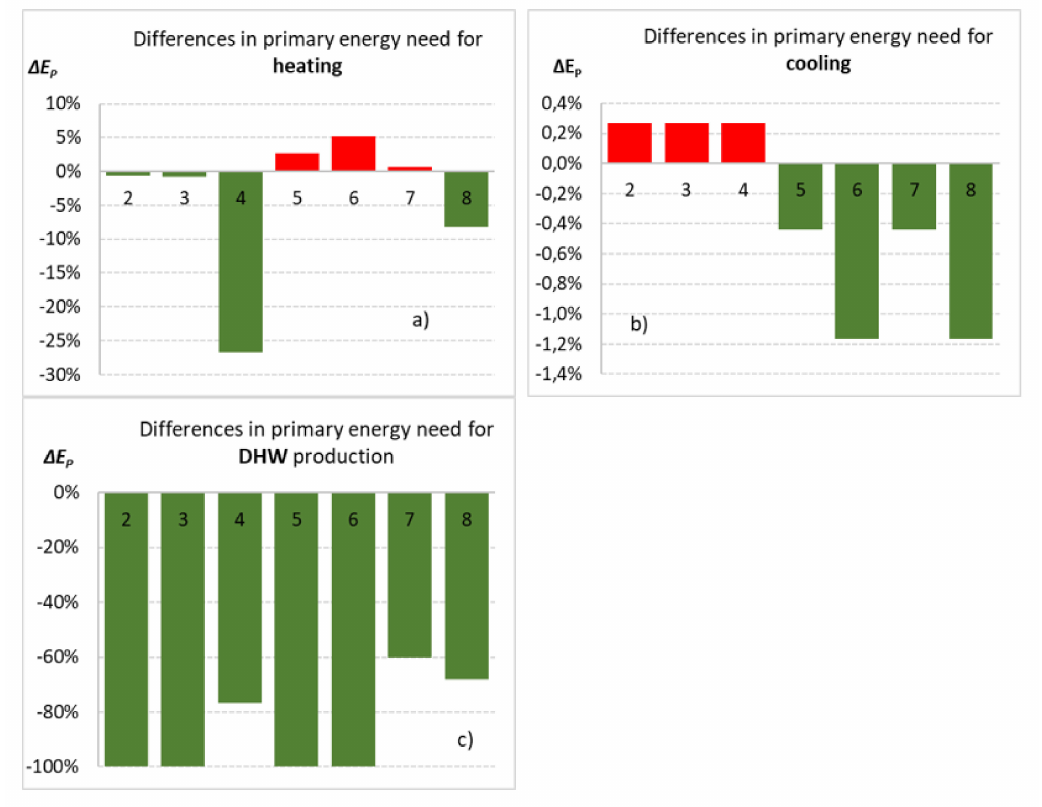
Figure 13. Di ff erences in primary energy need for each scenario respect to the reference